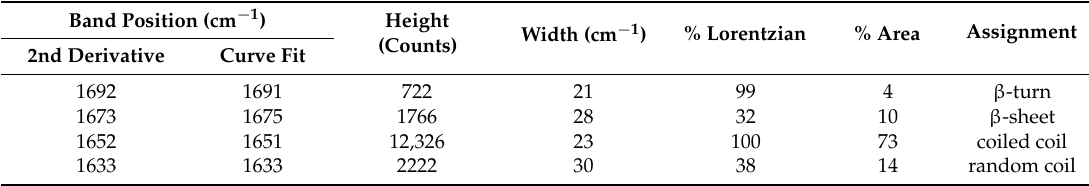
Figure 4. The Raman amide I band of the hand drawn B. terrestris fibre. Spectral deconvolution ( a ); the underlying black trace represents the raw data, the red trace is the sum of the component peaks (dark grey) and components that are not associated with protein conformation and present for fitting purposes only (light grey). Polarized Raman spectra ( b ). Table 2. Amide I band deconvolution component parameters and assignments for the hand drawn B. terrestris